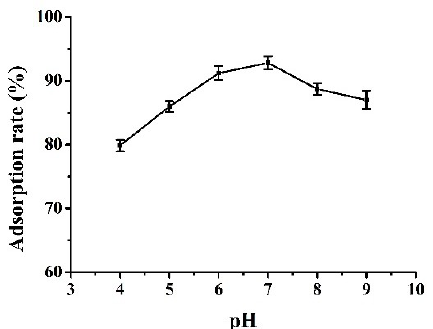
Figure 6. The influence of pH on the adsorption. A mass of 50 mg adsorbents in 10.0 mL solution (10 mg/L BPA); 34 mmol/L PBS; 25 °C. The error bars represent standard deviation of three parallel experiments.